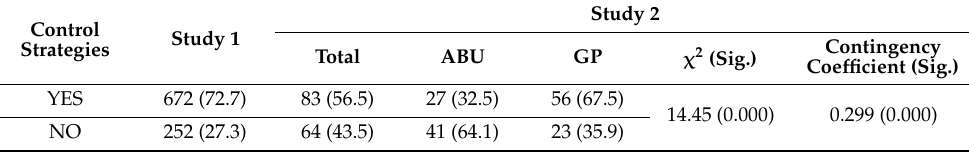
Table 4. Perception of drug use control for the whole sample. Control